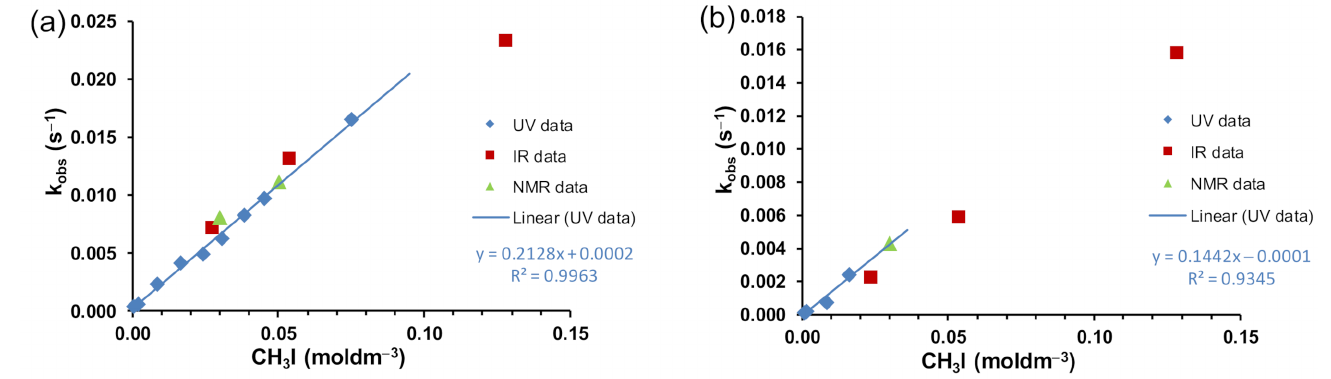
Figure 7. Observed kinetic rate constants for obtained through UV–Vis spectroscopy, IR spectroscopy, and NMR spectroscopy, at 25 ◦ C, for the reaction between CH 3 I and ( a ) [Rh(CH 3 COCHCNHCH 3 ) (CO)(PPh 3 )] 3B and ( b ) [Rh(CH 3 COCHCNPhCH 3 )(CO)(PPh 3 )] 3A